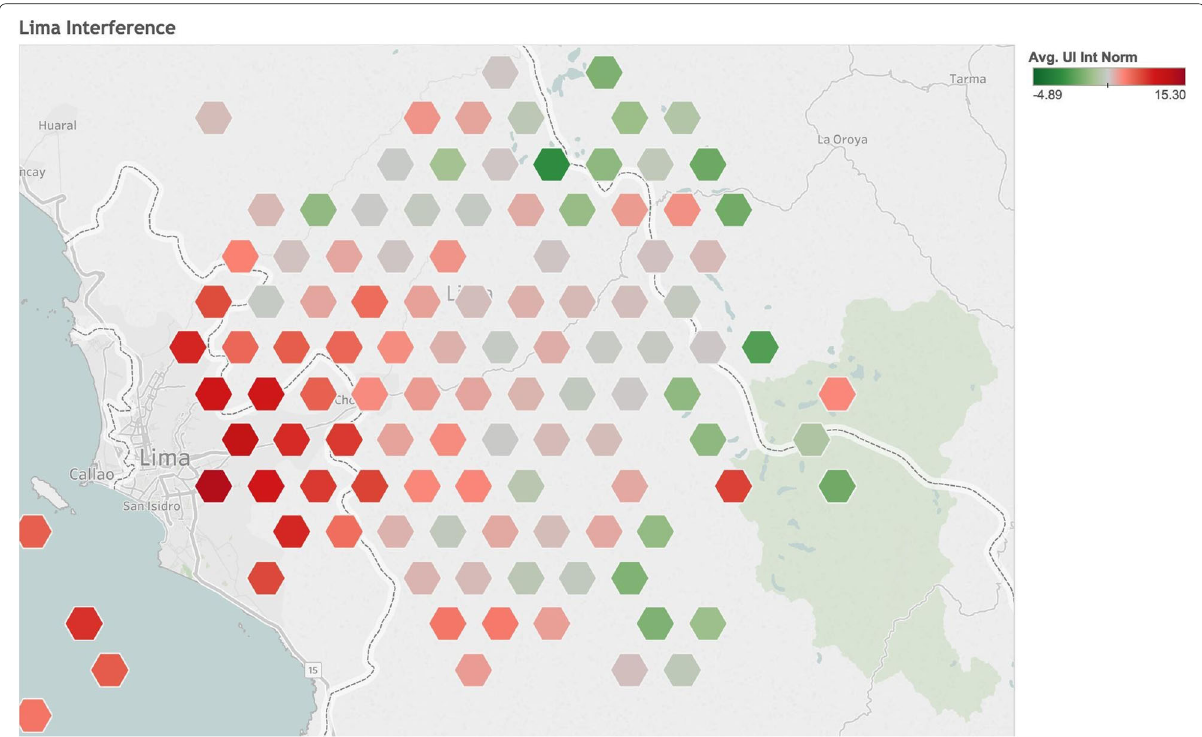
Fig. 17 UL Interference observed from Loon near